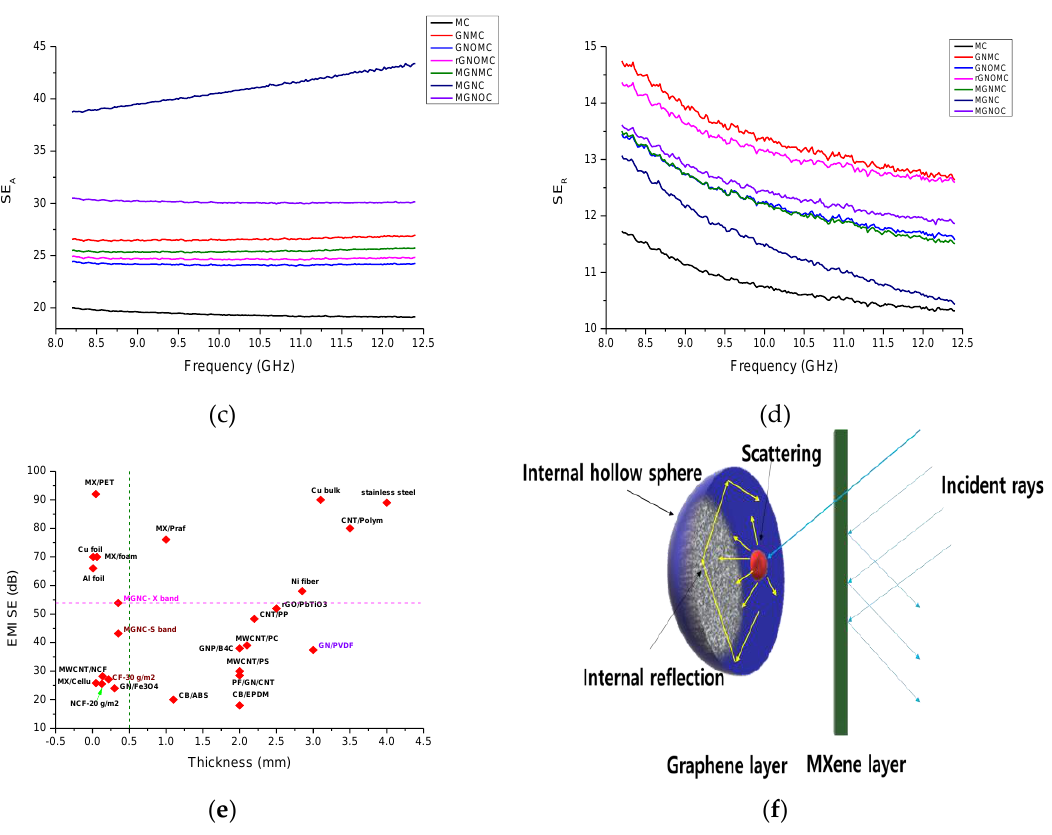
Figure 7. EMI shielding effectiveness of composites ( a ) EMI SE in S-band, ( b ) EMI SE in X-band, ( c ) SE R , ( d ) SE A , ( e ) comparison of EMI SE with thickness and ( f ) Basic mechanism in MGNC.